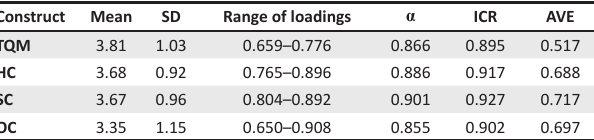
TABLE 1: Internal consistency reliability and convergent validity. Construct